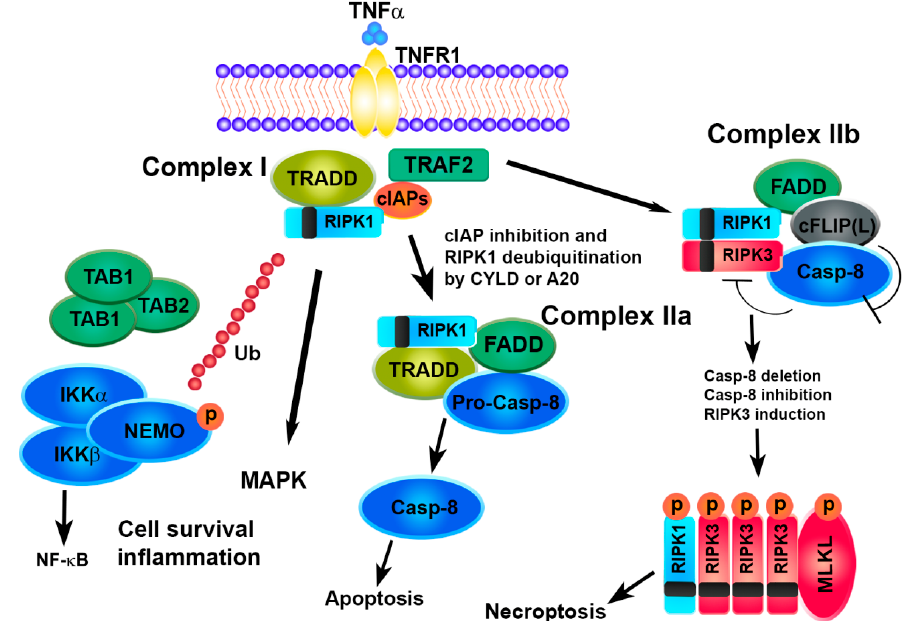
Figure 2. Survival or cell death pathways activated by TNF α /TNFR1. TNF α , tumor necrosis factor alpha; TNFR1, tumor necrosis factor receptor; TRADD, TNFR-associated death domain; TRAF2, TNFR-associated factor, cIAPs, cellular inhibitors of apoptosis protein, RIPK, receptor-interacting protein kinase, TAK1, transforming growth factor-activated kinase 1; TAB, TAK1-binding